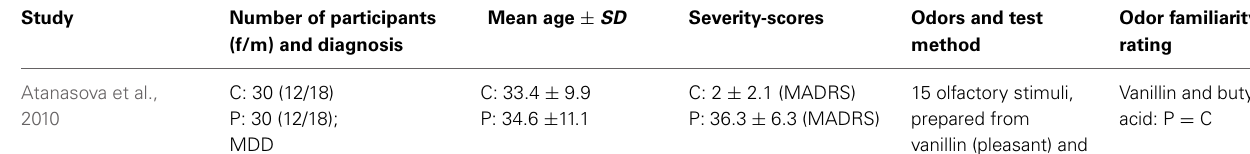
Table 6 | Summary of studies of odor familiarity ratings in affective